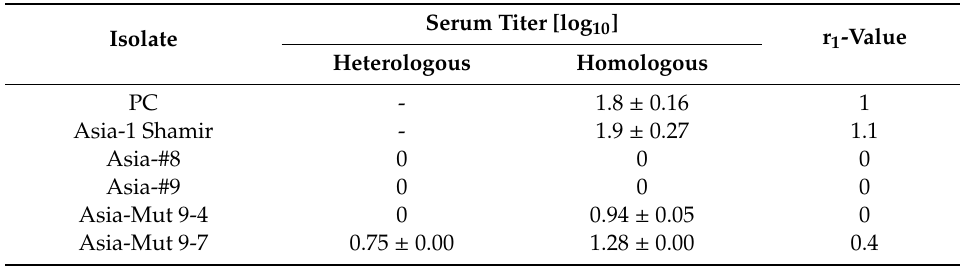
Table 6. Virus neutralization titers for the vaccine candidates and the corresponding r 1 -values relative to the PC.